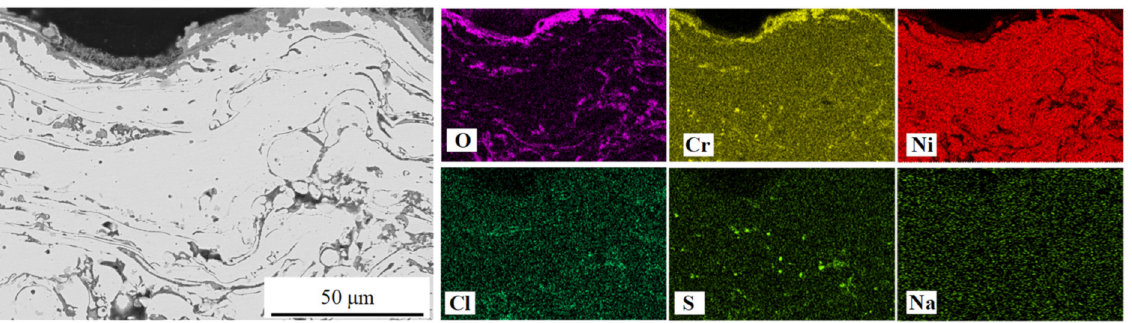
Figure 9. The elemental mappings of a cross-section of NiCrB-Air coating after the hot corrosion